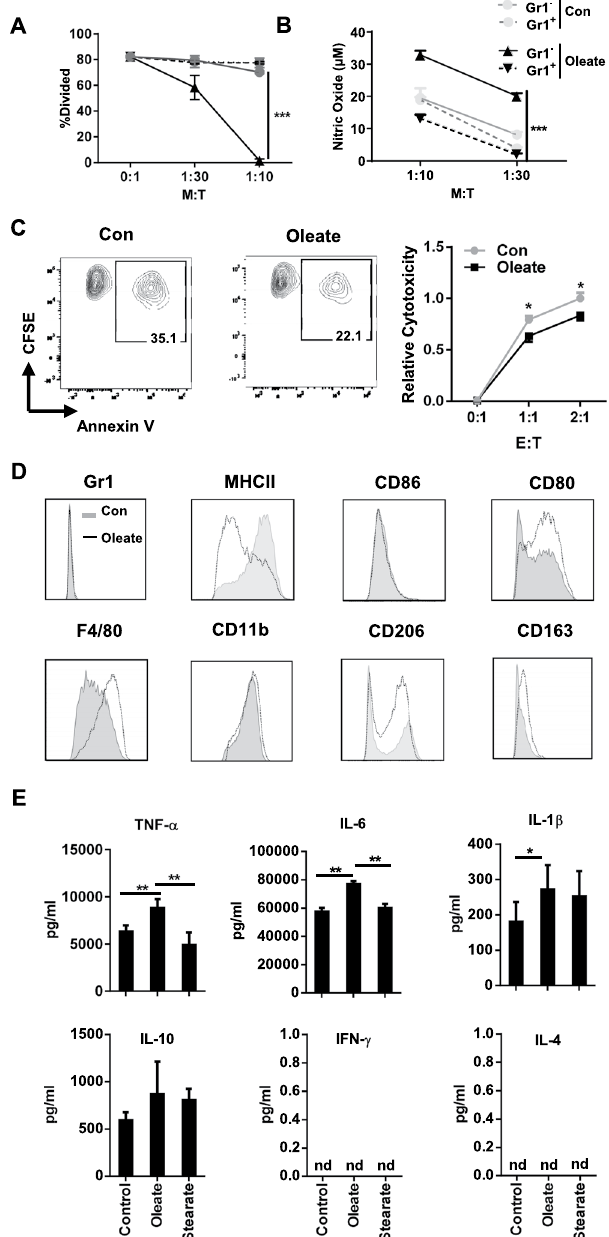
Figure 7. Gr1 − but not Gr1 ± cells exhibit enhanced immunosuppressive capacity after oleate treatment. Bone marrow cells were polarized in the presence of 40 ng/ml GM-CSF and treated with the indicated compounds for 7 days. Gr + and Gr1 − populations were purified via beads and co-cultured with purified CD4 + T cell in the ratios indicated for functional assay ( A ). NO production from the co-culture supernatant was quantified by Griess reaction ( B ). CTLs were polarized and coincubated with purified Gr1 − cells for 18 hours. The suspension cells were harvested and cocultured with CFSE labelled E.G7 OVA cell line for 90 mins. The proportion of Annexin V + cells gated from CFSE + population was used to calculate the cytotoxicity of CTLs (Formula in the Methods section) ( C ). Surface marker panel of Gr1 − cells from either control or oleate group was performed via flow cytometry ( D ). Purified Gr1 − cells were stimulated by 1 µ g/ml LPS in 24 hours and then supernatants were collected for cytokine analysis ( E ). Shown is the mean ± SD from two to four independent experiments. * p < 0.05; ** p ≤ 0.01; *** p ≤